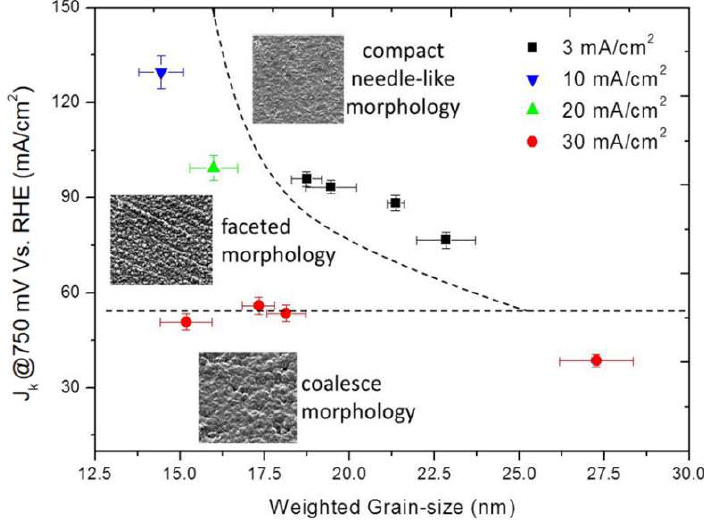
Figure 5. Structural phase diagram showing the kinetic current density at 750 mV vs. RHE as function of weighted grain size and morphology.